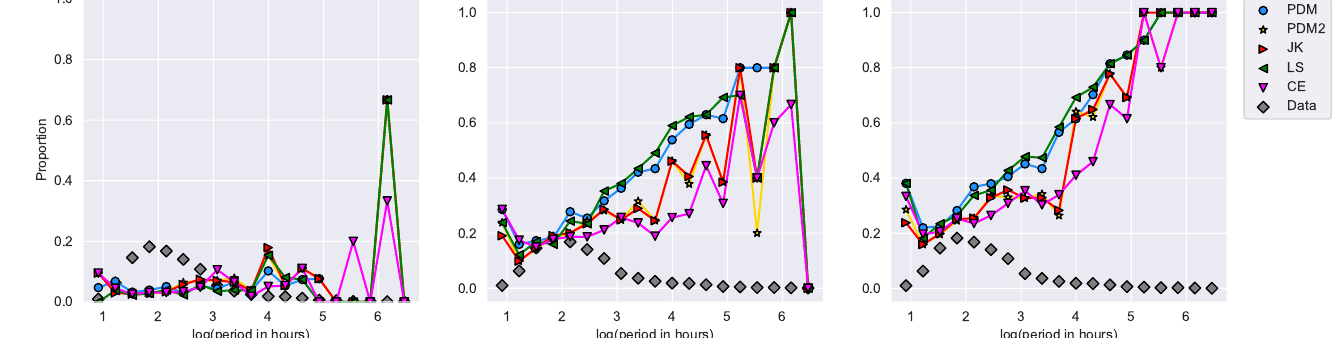
Figure 13. The comparison of different period finding algorithms considering the different reported periods for the step size of 10 − 3 h of and the range of 2 h–750 h of period searching. The criterion for comparison is the proportion of asteroids having a successful periodic recovery. From left to right, the three plots are for different δφ max = 85/50,850/50 and 8500/50. The gray diamonds indicate the proportion of asteroids at the corresponding reported period in our data set.